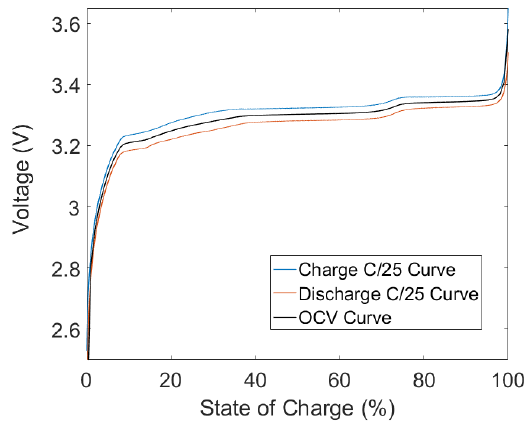
Figure 7. The open circuit voltage obtained by averaging the C/25 charge and discharge curves.